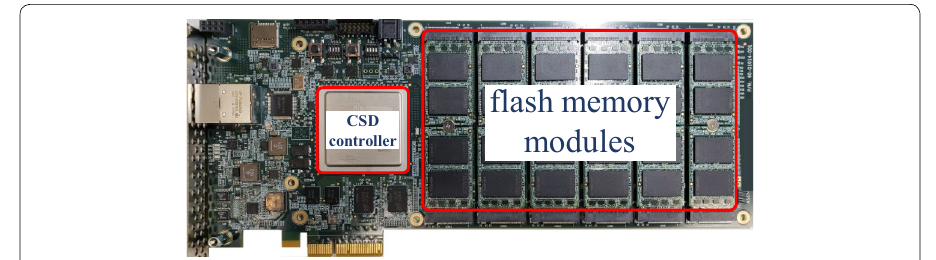
Fig. 6 Catalina CSD prototype